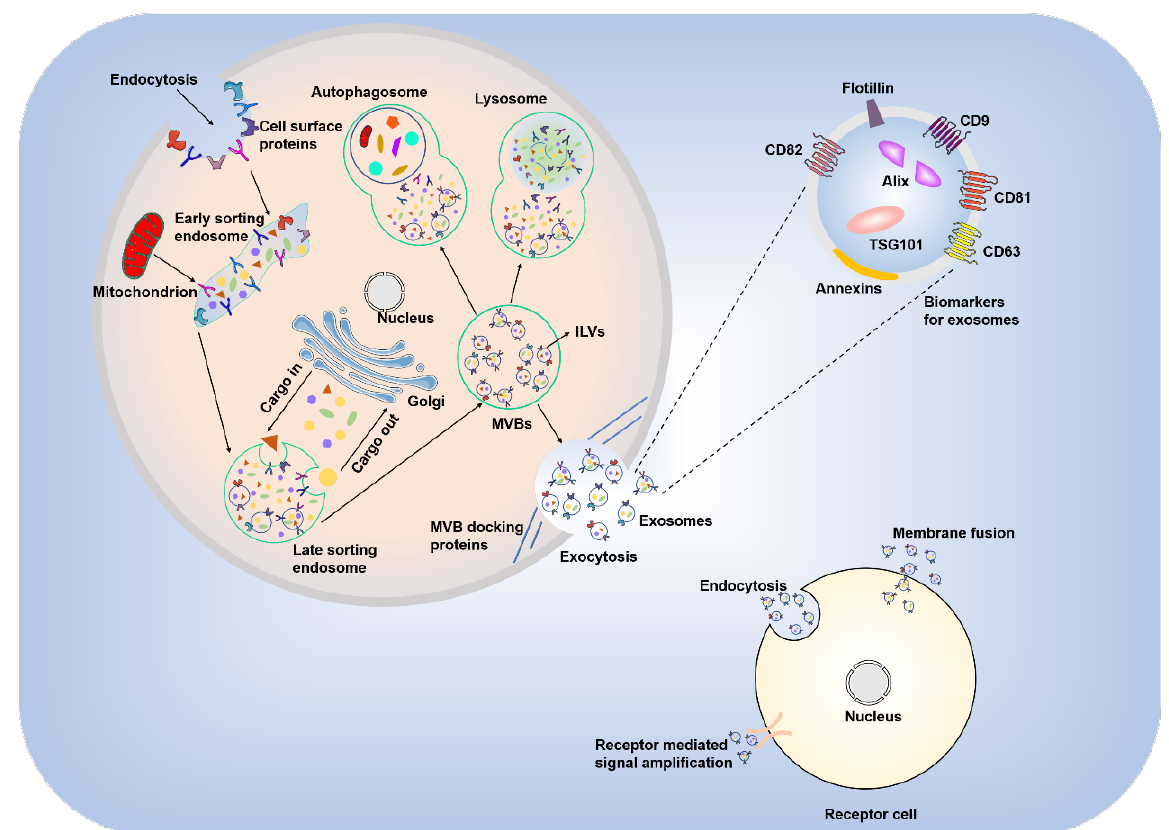
Figure 1. Exosomes biogenesis, surface markers and information exchange patterns. The cell membrane invaginates to form early endosomes, and multiple proteins, RNA, and DNA continue to accumulate to form late endosomes, further forming MVBs, which fuse with the plasma membrane to form and release exosomes. The biomarkers of exosomes include CD9, CD81, CD63, CD82, flotillin, annexins, Alix, TSG101, etc. Recipient cells will take up exosomes through cytokinesis, membrane fusion and receptor-mediated internalization. MVBs: Multivesicular bodies; ILVs: Intraluminal vesicles; TSG101: Tumor susceptibility gene 101 protein; Alix: ALG-2-interacting protein X. Exosomes contain a variety of molecules, including proteins, lipids, DNA and